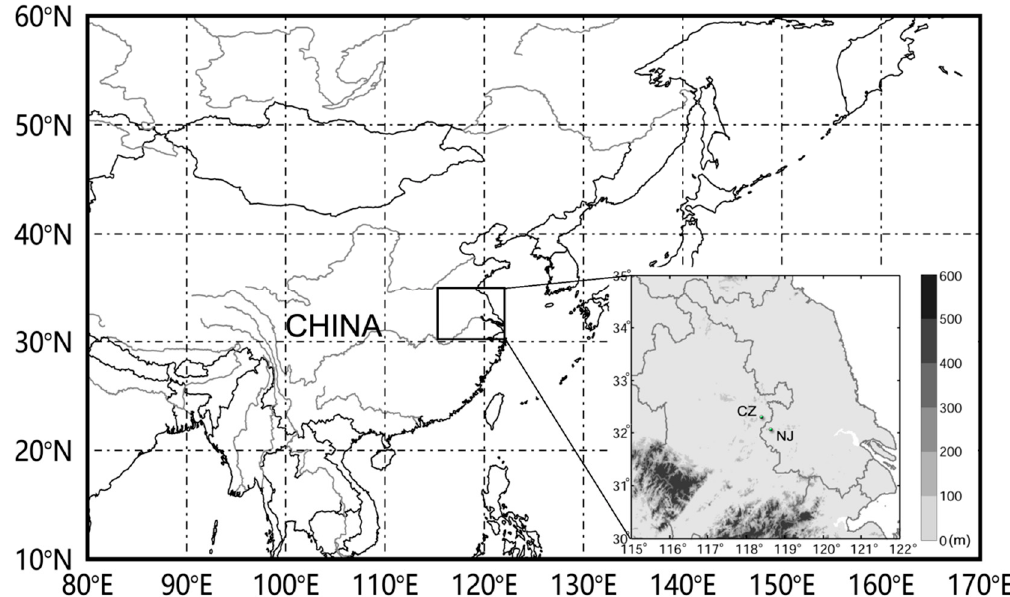
Figure 1. Locations of two observational sites (Nanjing (NJ) and Chuzhou (CZ)) over Jianghuai region. The superimposed rectangle represents Jianghuai region. Table 1. Precipitation events used for the present study in two seasons of 2014.